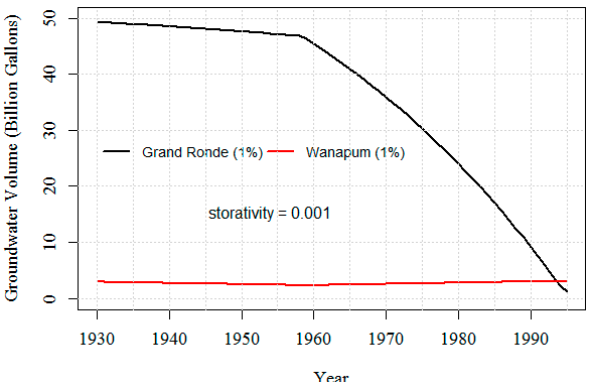
Figure 6. Simulation result of the volume of water in Wanapum and Grande in a billion gallons (1% population growth) assuming no recharge to Grand Ronde.